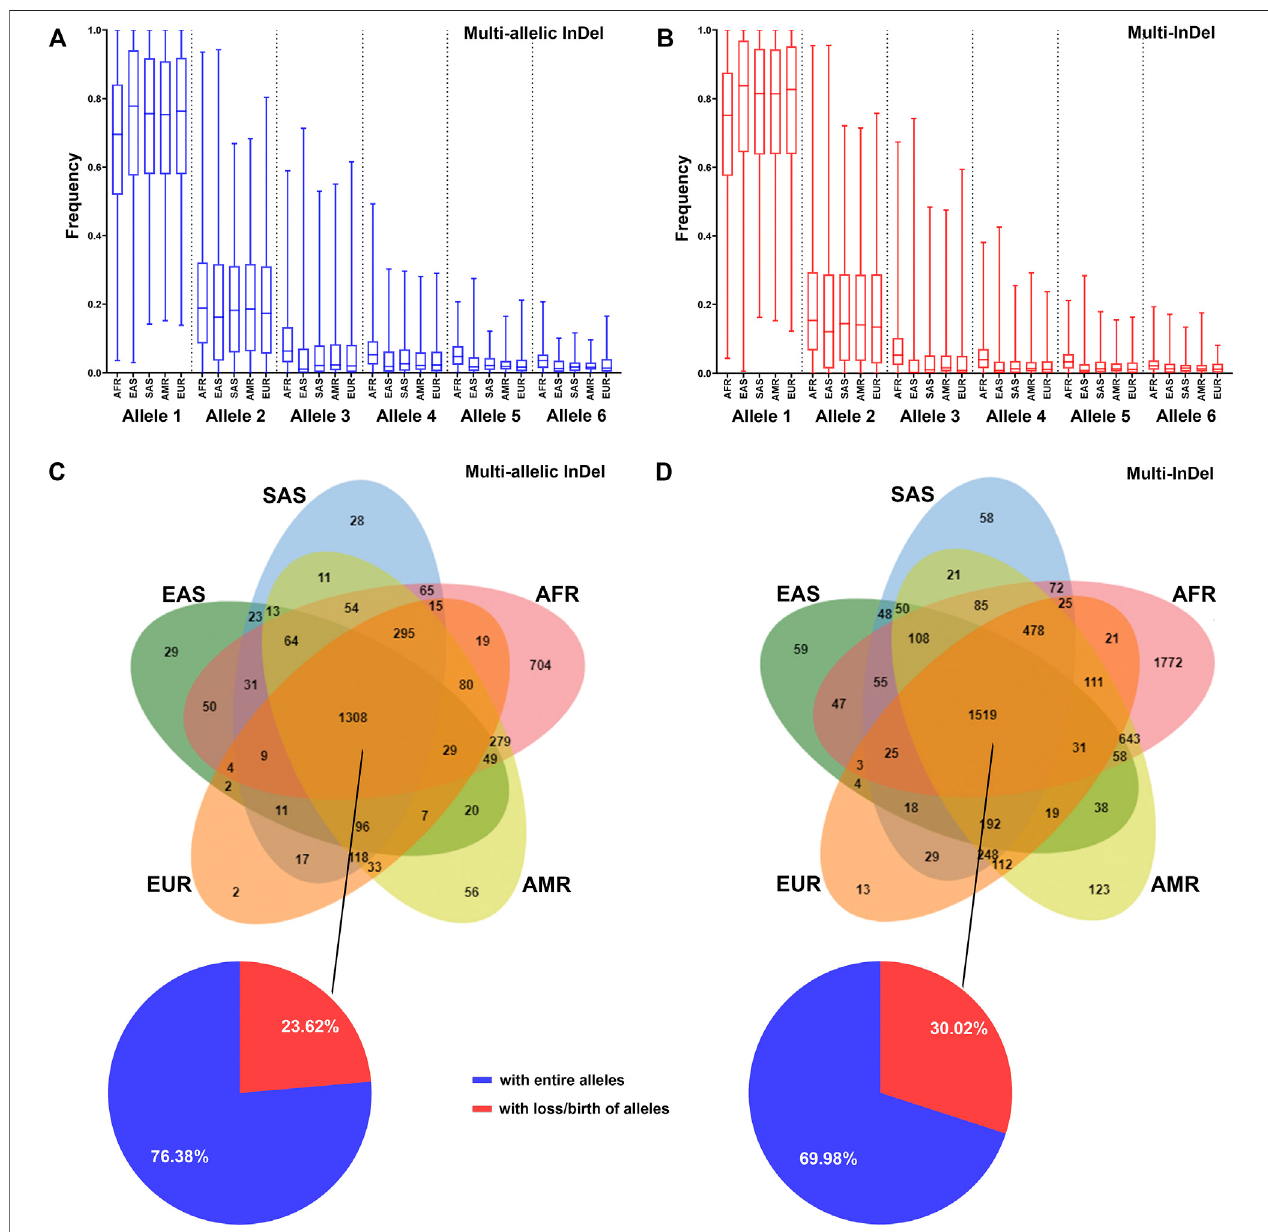
FIGURE 5 | Distribution of MM-InDel markers in worldwide populations. (A,B) Allele frequency distributions of multi-allelic InDels with random sequences (A) and multi-InDels with random sequences (B) among the African ancestry population ( AFR ), American ancestry population ( AMR ), European ancestry population ( EUR ), East Asian ancestry population ( EAS ), and South Asian ancestry population ( SAS ). Alleles were sorted in a descending order by frequency at each marker in the total population. (C,D) Venndiagramshowingthedistributionsofmulti-allelicInDelswithrandomsequences (C) andmulti-InDelswithrandomsequences (D) indifferent populationcohorts. The overlapping regionindicates thenumber ofMM-InDelswith threeor more alleles.The pieplotindicates theproportions ofMM-InDelswith entire alleles ( blue ) or with loss/birth of alleles ( red ) in the populations.